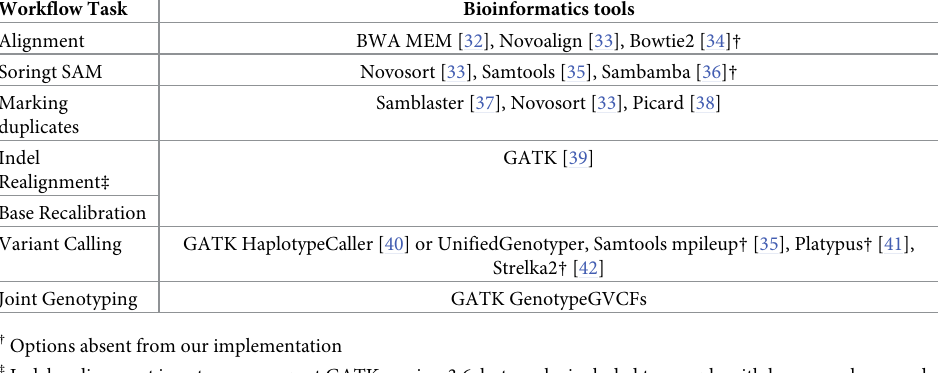
Table 1. Tools commonly used in genomic variant calling